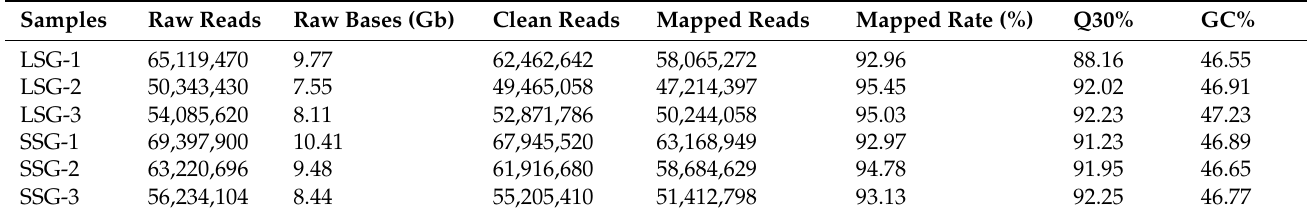
Table 1. Overview of the sequencing data.